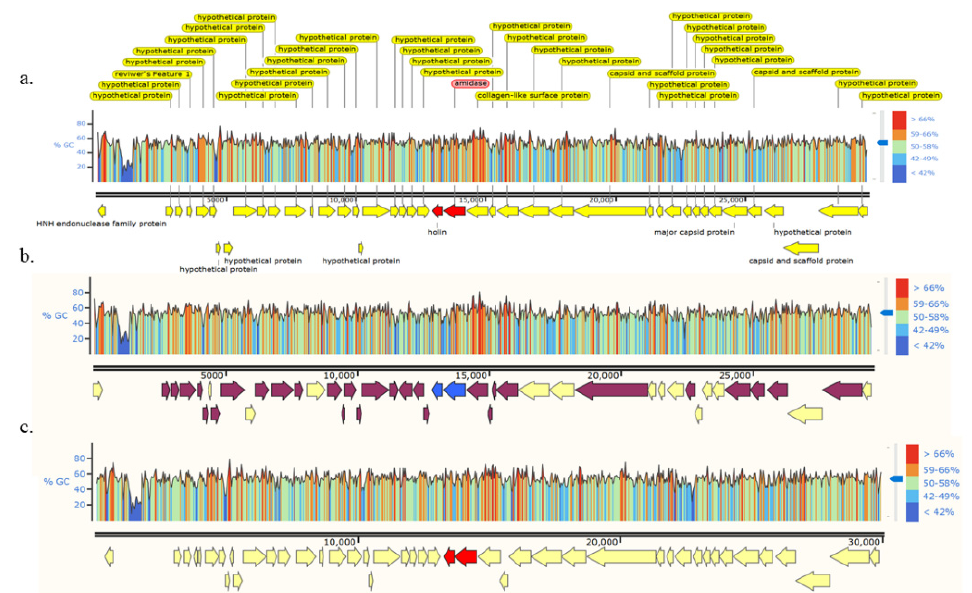
Figure 2. Genomes and open reading frames (ORFs) of three isolated phages, i.e., 2012-15 ( a ), p2 ( b ), and P2 ( c ). Identical ORFs across the phages (yellow arrow); those of the P1 phage were not identical with those of the 2012-15 and P2 phages (maroon arrows); holing (small blue and red arrows) and endolysin (large blue and red arrows) are shown. The arrangement of the ORFs was nearly identical across all three phages, as were the GC contents of each genome ( Y axis).